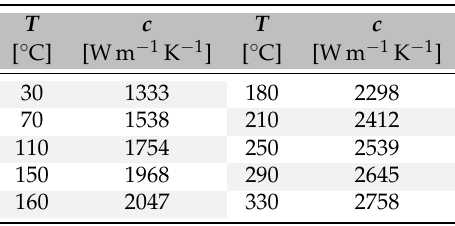
Table A2. The specific heat of TOPAS 6017